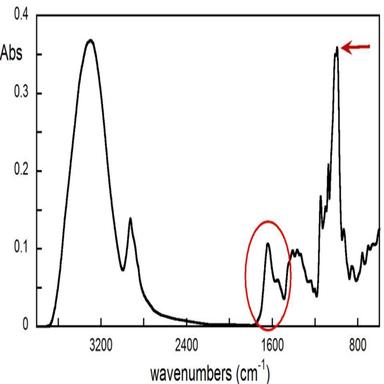
FTIR spectrum of the page 230 of the volume 410. The arrows indicate the band attributable to starch, while circle to molecules from cellulose degradation containing carbonyl and carboxyl groups.